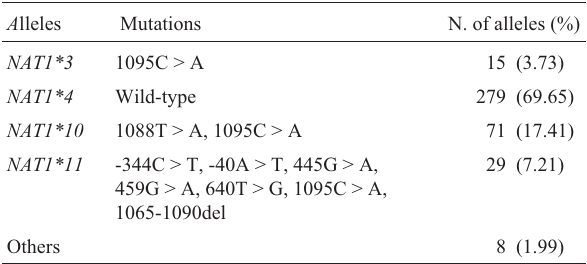
Table 2 - Frequencies of NAT1 alleles in a sample from the Turkish